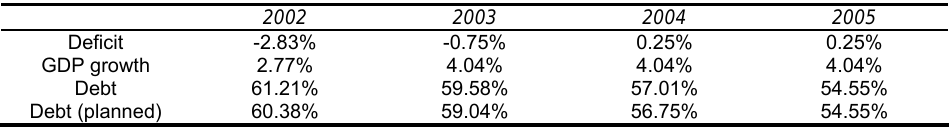
Table 4. German government deficit plan after a one-time deviation and revision